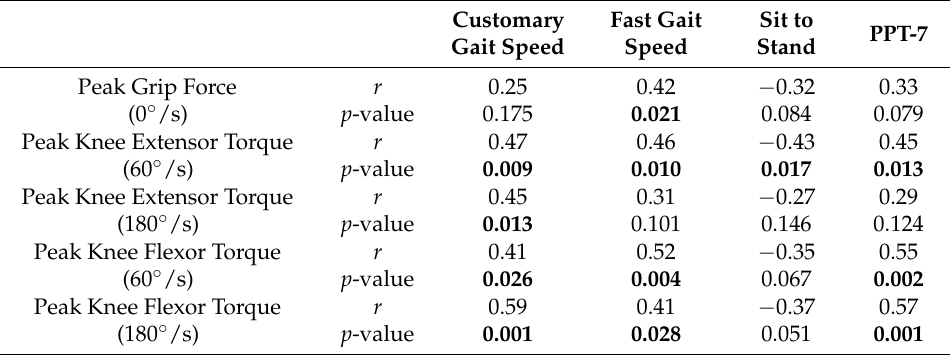
Table 3. Strength-function relationships.